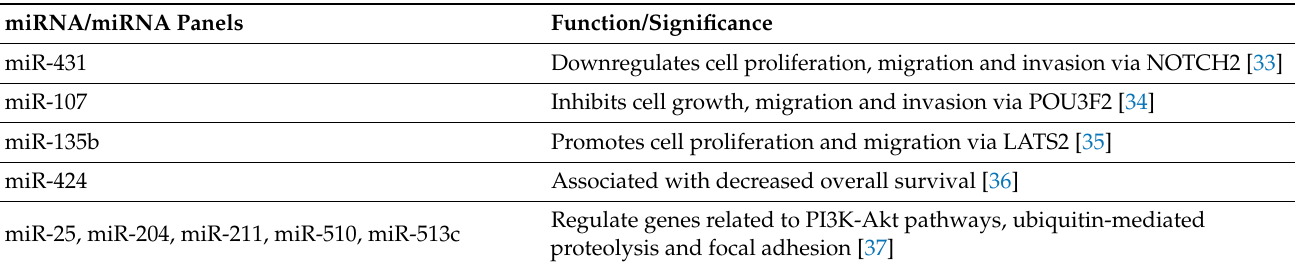
Table 1. Summary of the novel miRNAs or miRNA panels in